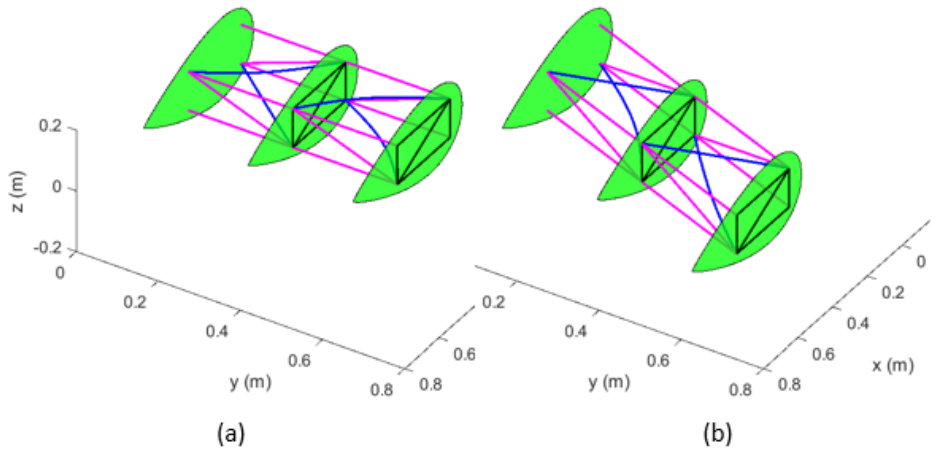
Figure 12. Fourth mode shape for the system in the ( a ) un–morphed configuration, ( b ) morphed configuration (simulation